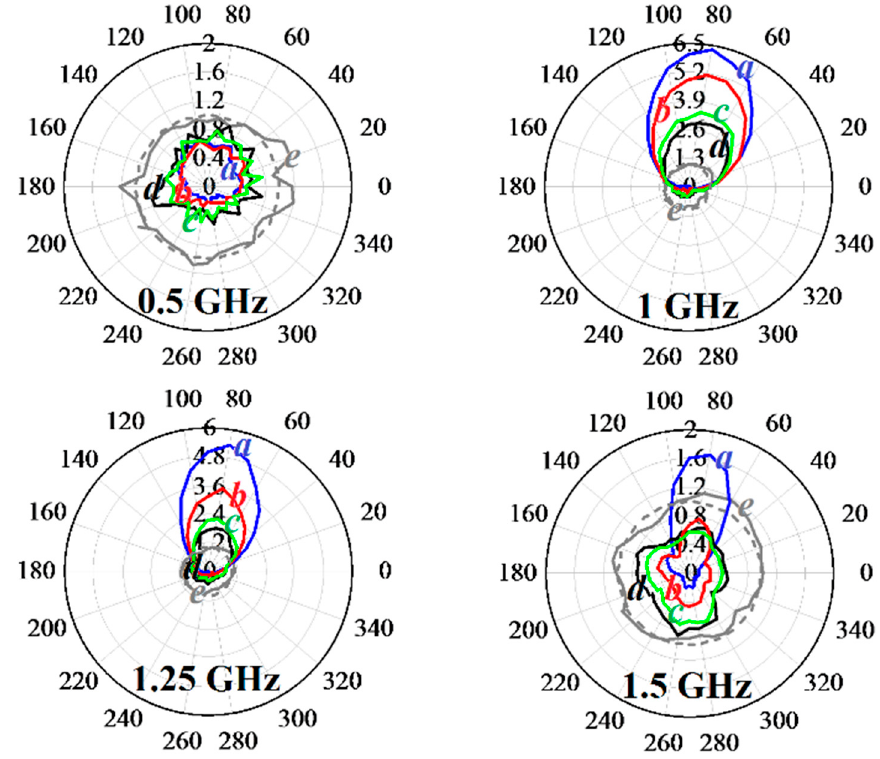
Figure 6. Radiation patterns for the third lamp configuration at different frequencies and discharge currents. The curve designations ( a – e ) correspond to those in Figure 4. Table 3. Antenna system directivity (dB) for the third lamp configuration.